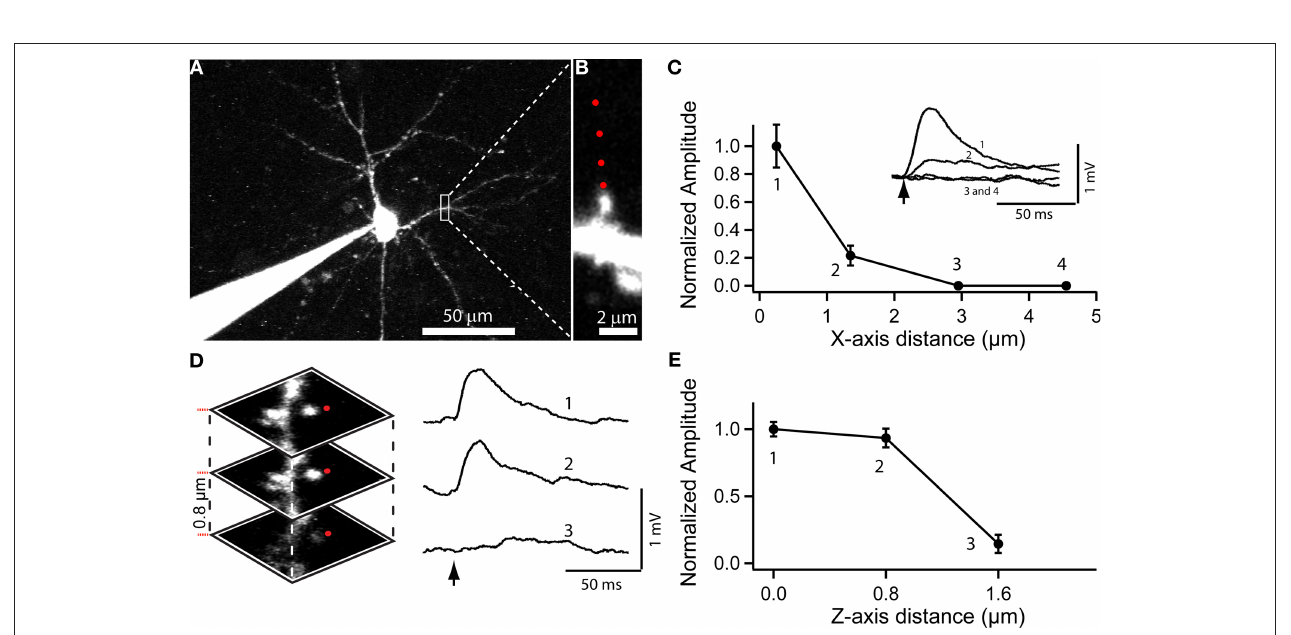
Here we show examples of IPSCs evoked in control conditions, and the diminution of their amplitude after adding either RuBi-Glutamate (300 µM, left part) or MNI-Glutamate (300 µM or 2.5 mM, right part) to the bath. (B) Histogram showing averages of the inhibition of GABA current in presence of RuBi-Glutamate or MNI-Glutamate. ** p < 0.01, *** p <